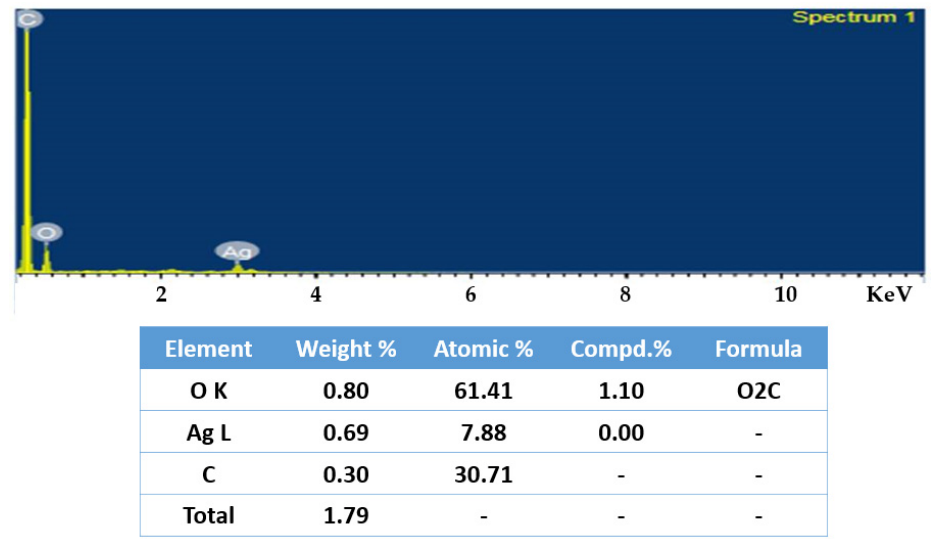
Figure 3. SEM images of R. apiculata AgNPs show an uneven shape and a diameter of 35–100 nm.